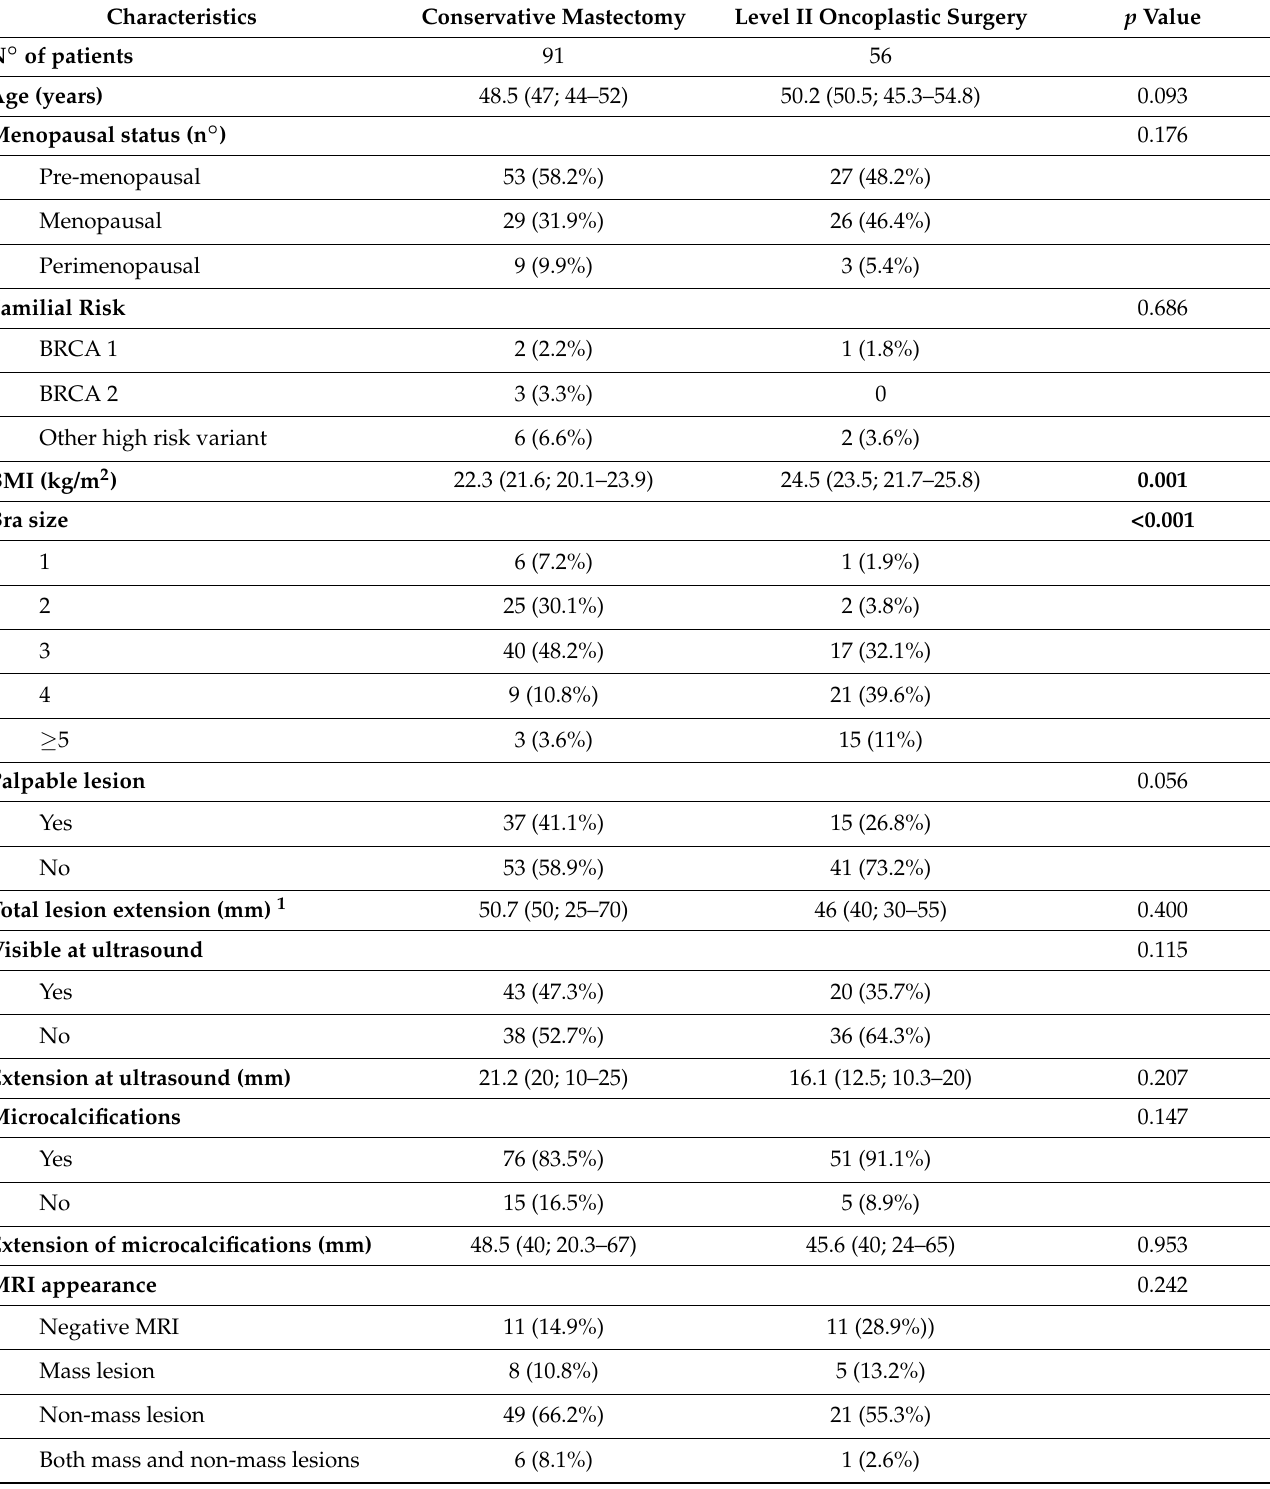
Table 2. Preoperative Tumor